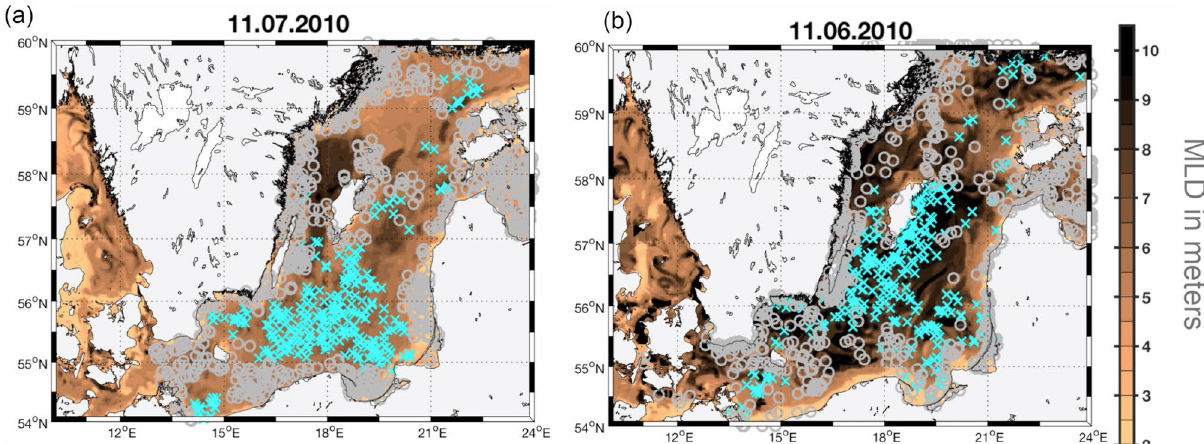
Figure 1. Exemplary back-tracing of a cyanobacteria bloom event. Panel ( a ) shows the random seeding of virtual drifters during a blooming picked up by satellite on July 11th 2010. The crosses (circles) denote drifters seeded into (non-) blooming patches. Unclassified patches are not seeded. Panel ( b ) shows the back-traced positions of the drifters 30 days prior to the blooming event. The color shading indicates surface mixed layer depth in meters. This figure was created with Matlab (https:// www. mathw orks. com/ produ cts/ matlab.